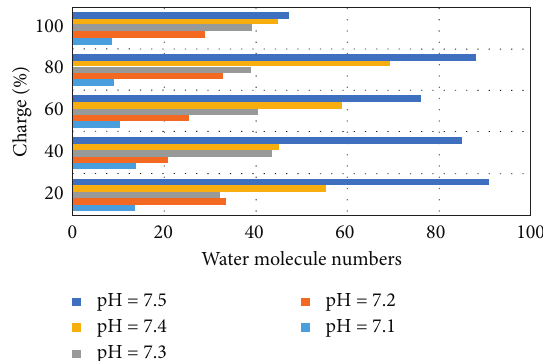
Figure 3: The number of leaked water molecules varies with